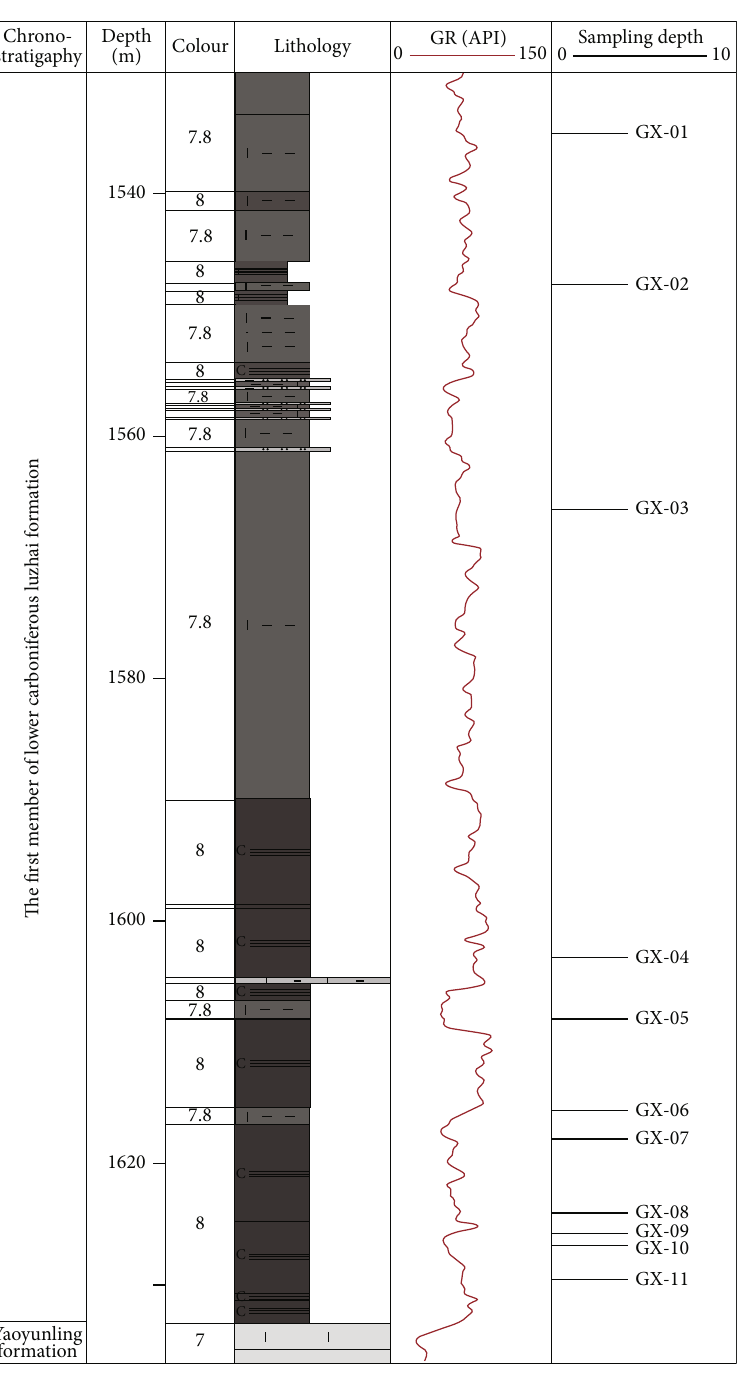
Figure 2: Comprehensive histogram and sampling location of the fi rst member of the Carboniferous Luzhai